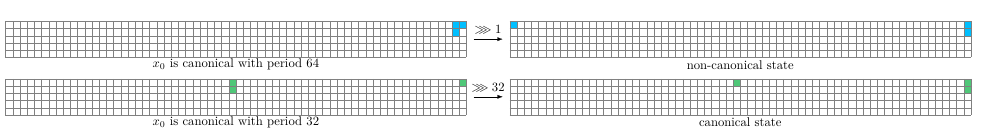
Figure 6: The row x 0 in the left states is canonical with different period. In the top figure, since the period of x equals the row length, translation results in a non-canonical state. 0 In the bottom figure since the period of x is smaller than the row length, translation can 0 result in a canonical